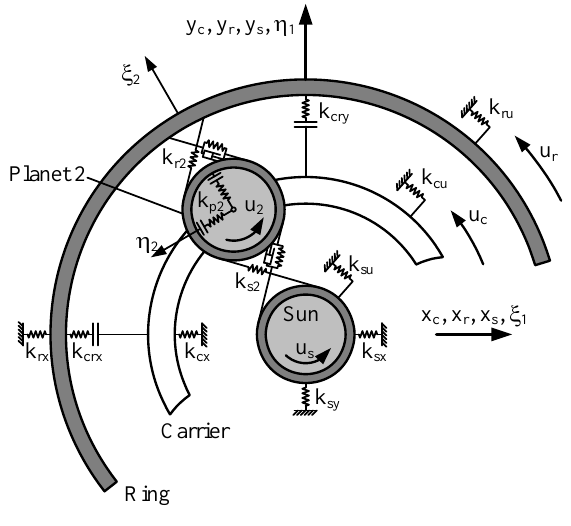
Figure 5: Lumped-parameter model as in Guo and Parker